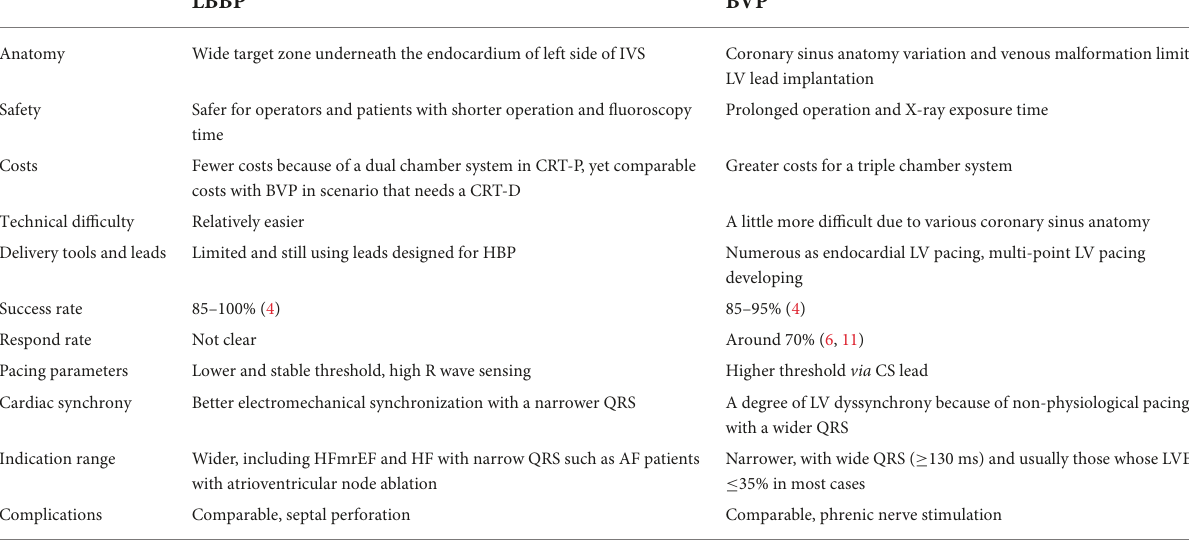
TABLE 2 Comparison of advantages and disadvantages between LBBP and